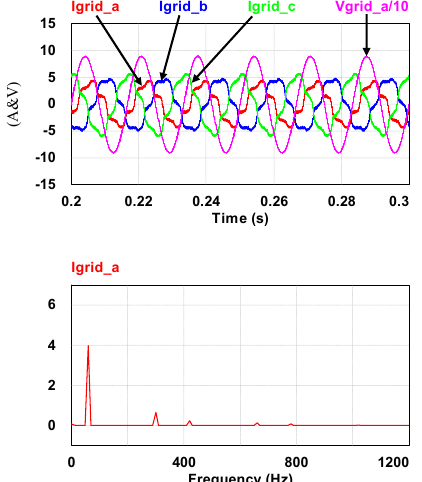
Figure 14. Before t 1 : the grid phase-a voltage and three-phase currents/the fast Fourier transform (FFT) waveform of the grid phase-a current.